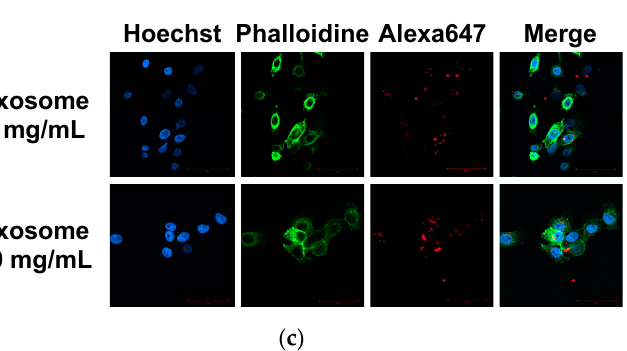
Figure 2. Cellular localization of fluorescently labeled anti-exosome antibodies (after 24 h of incubation) ( a ), analysis of the expression levels of antigens on the surfaces of exosomes and whole cell lysates by Western blotting ( b ), and exosome-dependent cellular uptake of anti-CD63 IgG in serum-free medium (after 12 h of incubation) ( c